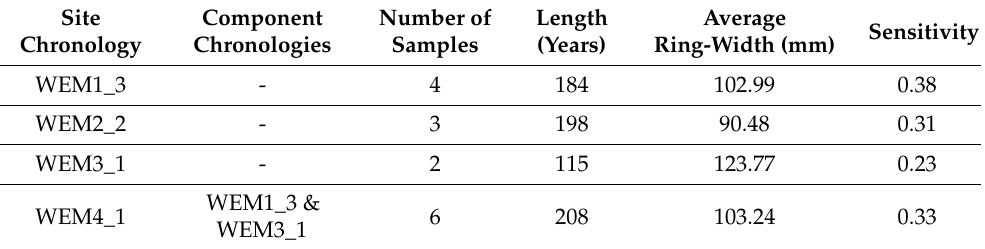
Table 2. Details of Wem Moss site tree ring-width